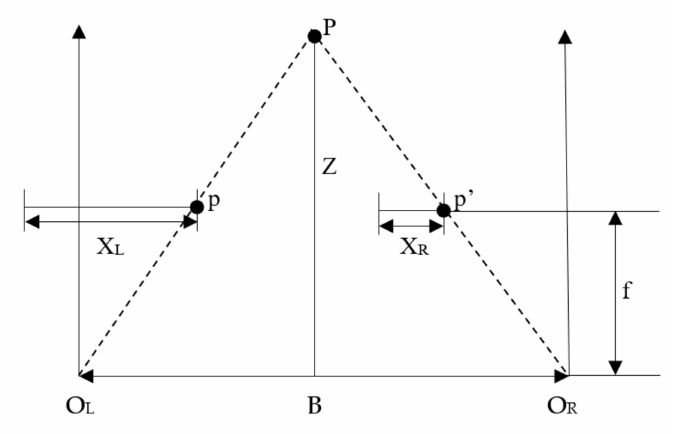
Figure 1. The stereo geometric model of binocular